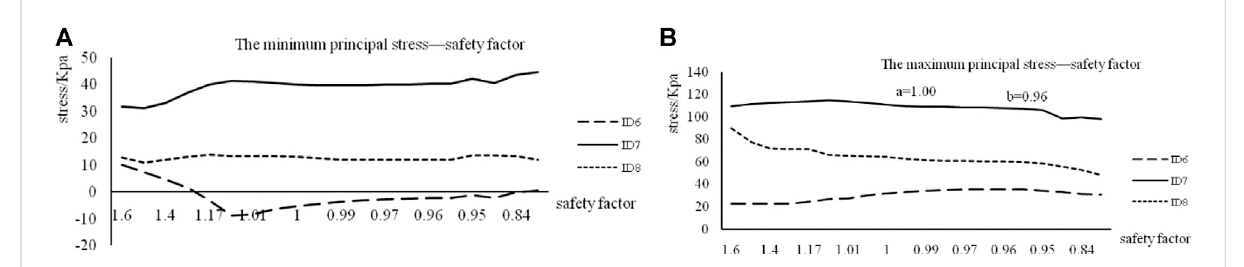
FIGURE 6 Stress – safety factor graph. (A) The minimum principal stress – safety factor. (B) The maximum principal stress – safety factor.